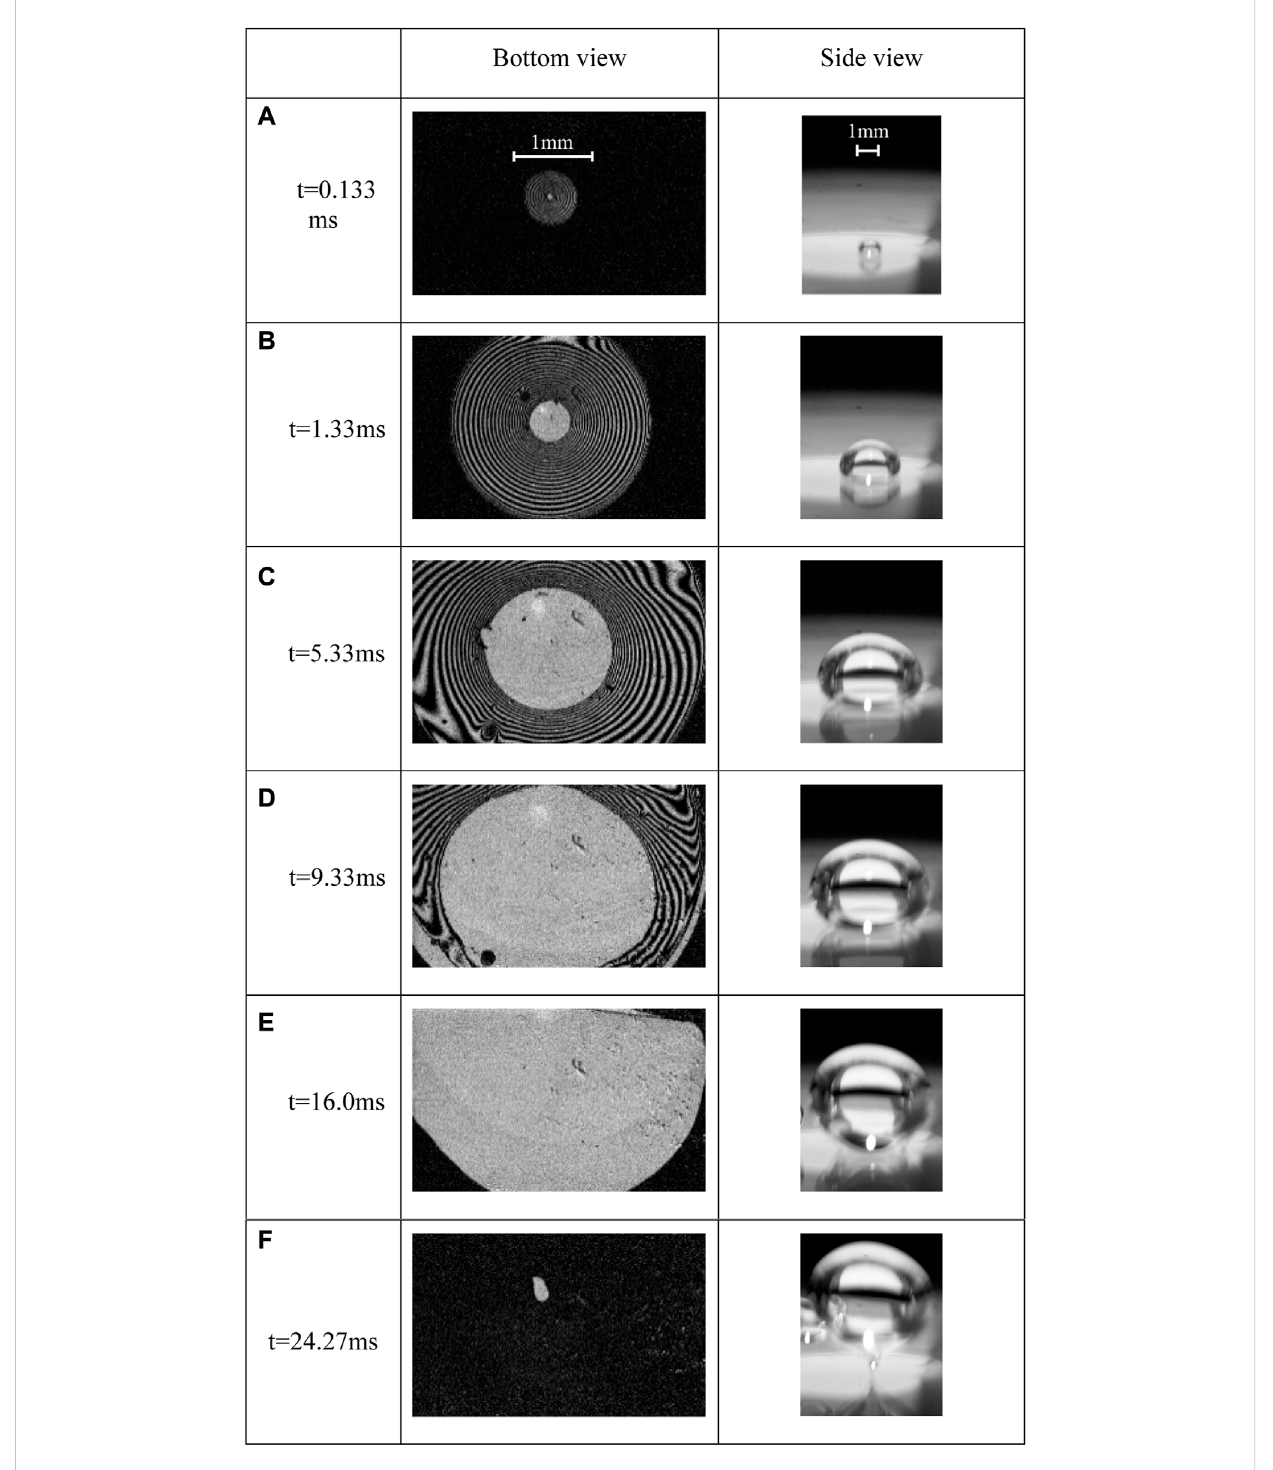
FIGURE 7 Interference fringes (left) and bubble side views (right) in case No.